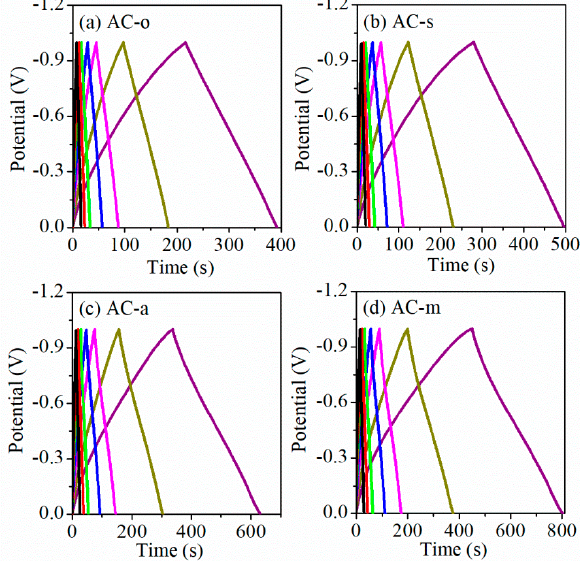
Figure 5. Charge-discharge curves of the samples at various current densities, from 0.5 to 10 A/g. (a) AC-o, (b) AC-s, (c) AC-a, and (d) AC-m.